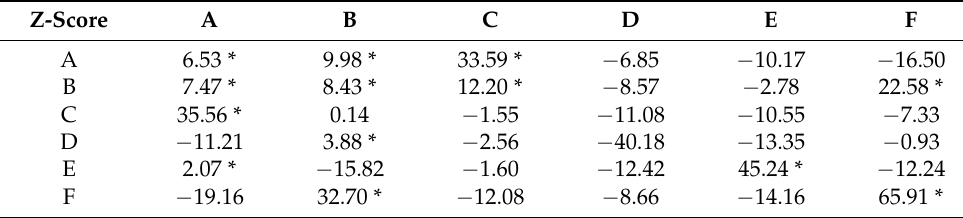
Table 5. Adjusted residuals table of the experimental